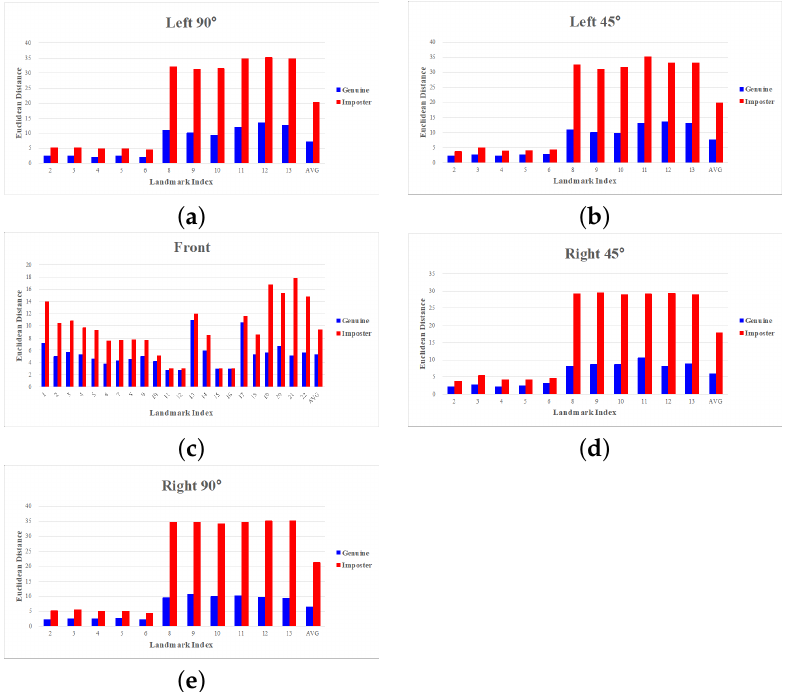
Figure 9. Average ED between each reciprocal landmark with different facial poses: ( a ) Left 90 ◦ ; ( b ) Left 45 ◦ ; ( c ) Front; ( d ) Right 45 ◦ ; ( e ) Right 90 ◦ .